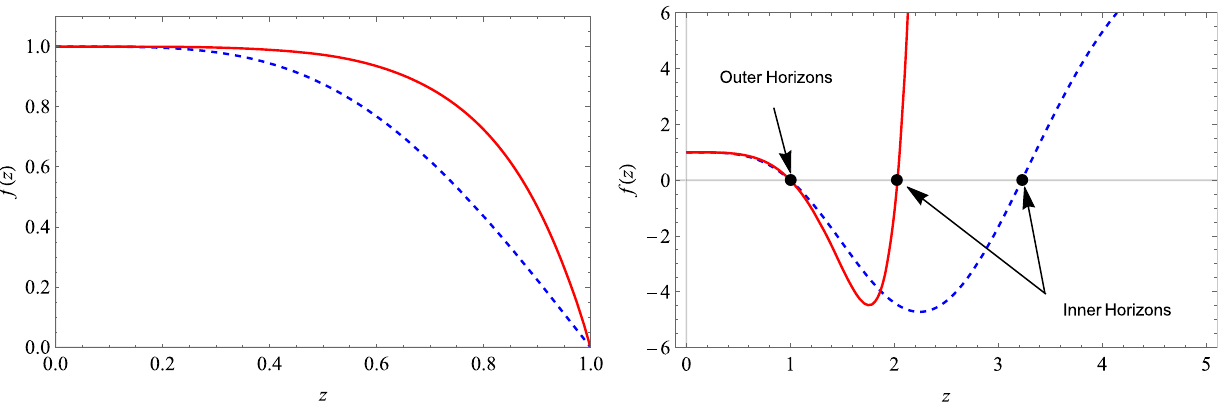
Fig. 1 Left panel: horizon function as a function o z for μ = 0. The dashed blue curve represents k = 1 and the red curve represents k = − 1. Right panel: horizon function as a function of z for μ = 0 . 8. The dashed blue curve represents k = 0 . 18 and the red curve represents k = − 0 .